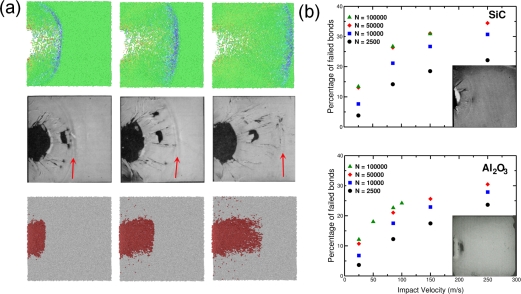
Results of a simulation of the edge-on-impact (EOI) geometry, cf. Figure 23, except this time, the whole macroscopic geometry of the experiment can be simulated while still including a microscopic resolution of the system. The impactor is not modeled explicitly, but rather its energy is transformed into kinetic energy of the particle bonds at the impact site. (a) Top row: A pressure wave propagates through the material and is reflected at the free end as a tensile wave (not shown). Middle row: The actual EOI experiment with a SiC specimen. The time interval between the high-speed photographs is comparable with the simulation snapshots above. The red arrows indicate the propagating shock wave front. Bottom row: The same simulation run but this time only the occurring damage in the material with respect to the number of broken bonds is shown. (b) Number of broken bonds displayed for different system sizes N, showing the convergence of the numerical scheme. Simulation parameters (α, γ, λ) are chosen such that the correct stress-strain relations of two different materials (Al2O3 and SiC) are recovered in the simulation of uniaxial tensile load. The insets show high-speed photographs of SiC and Al2O3, respectively, 4 μs after impact.